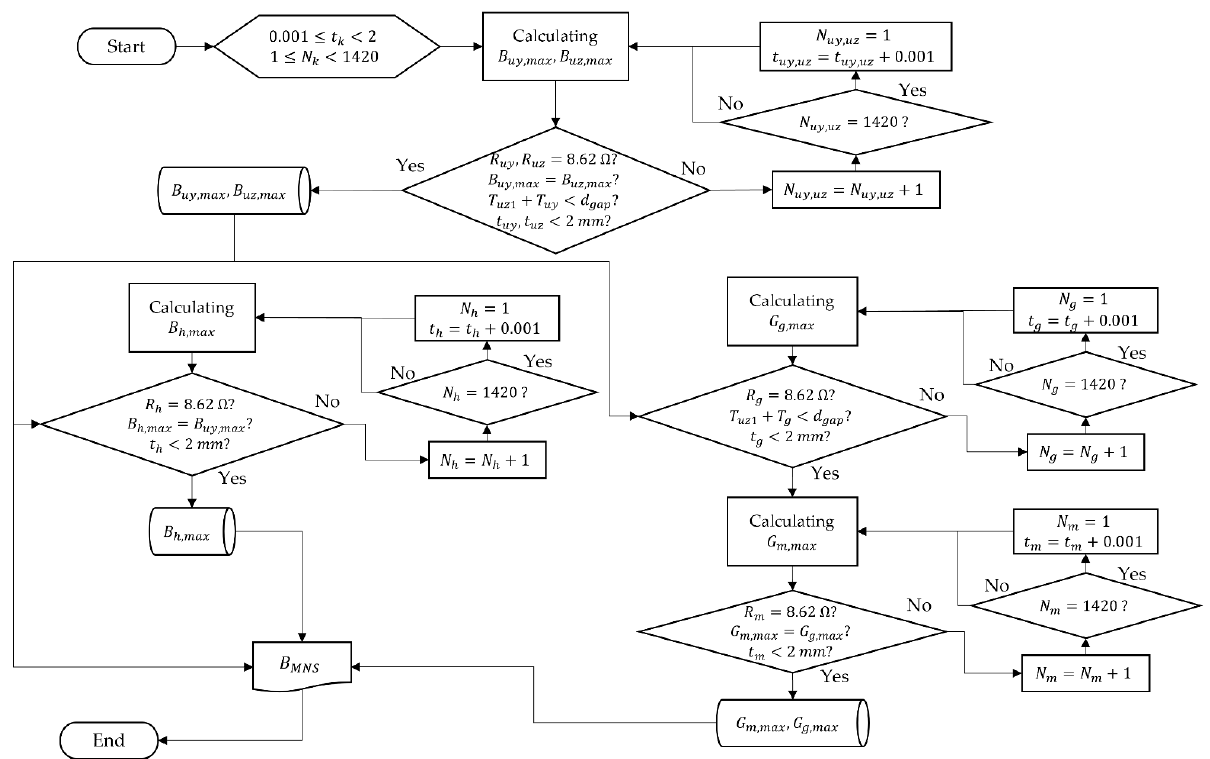
Figure 5. Optimization algorithm for the MNS with the given constraints. Table 1. Major variables of the optimized MNS.